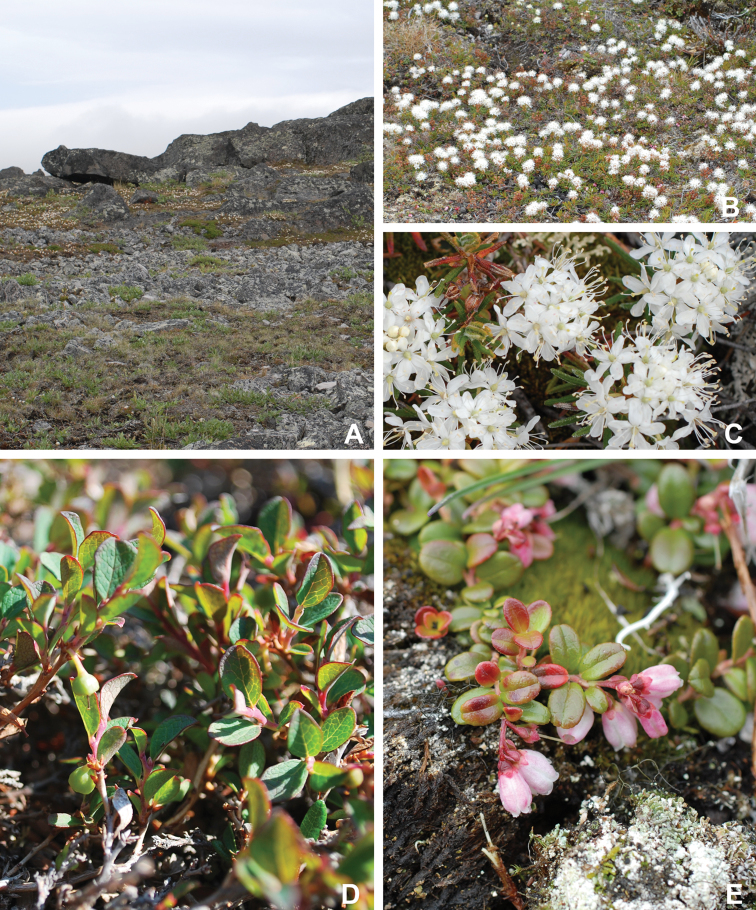
ARhododendron
tomentosum
subsp.
decumbens habitat, Gillespie et al. 7849BRhododendron
tomentosum
subsp.
decumbens habit, Gillespie et al. 7849CRhododendron
tomentosum
subsp.
decumbens inflorescence, Gillespie et al. 7849DVaccinium
uliginosum habit EVaccinium
vitis-idaea
subsp.
minus habit, Gillespie et al. 8037. Photos A, B, C by L.J. Gillespie D by B.A. Bennett and E by R.D. Bull.